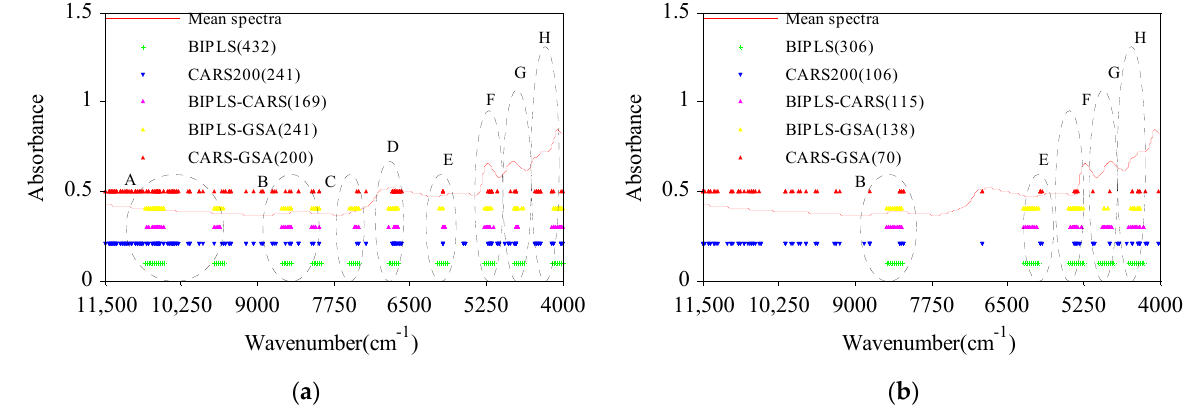
Figure 5. The characteristic wavelength variable distributions of cellulose ( a ) and hemicellulose ( b )